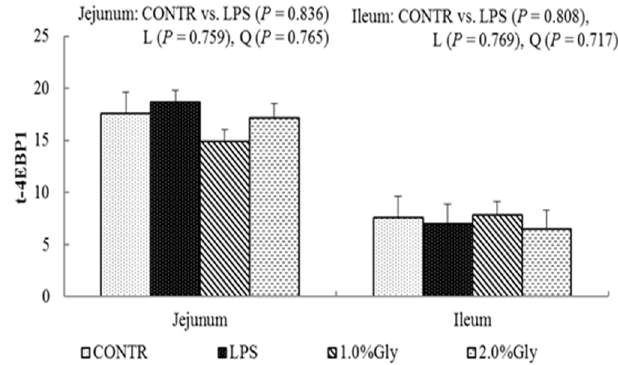
Figure 6. Effects of glycine supplementation on intestinal protein abundance of t-4EBP1 and p-4EBP1 after 4 h LPS challenge in weanling piglets. Note: L (linear), Q (quadratic). Table 5. Effect of glycine supplementation on intestinal mRNA expression of TLR4 and NOD and their downstream signals after 4 h LPS challenge in